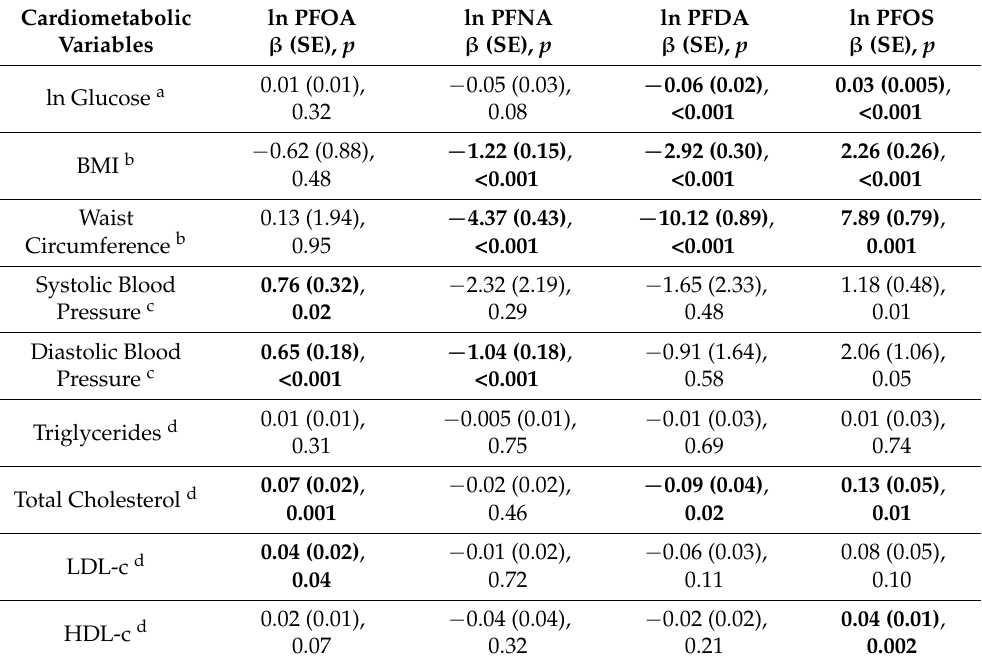
Table 5. Association between PFAS levels in blood and cardiometabolic